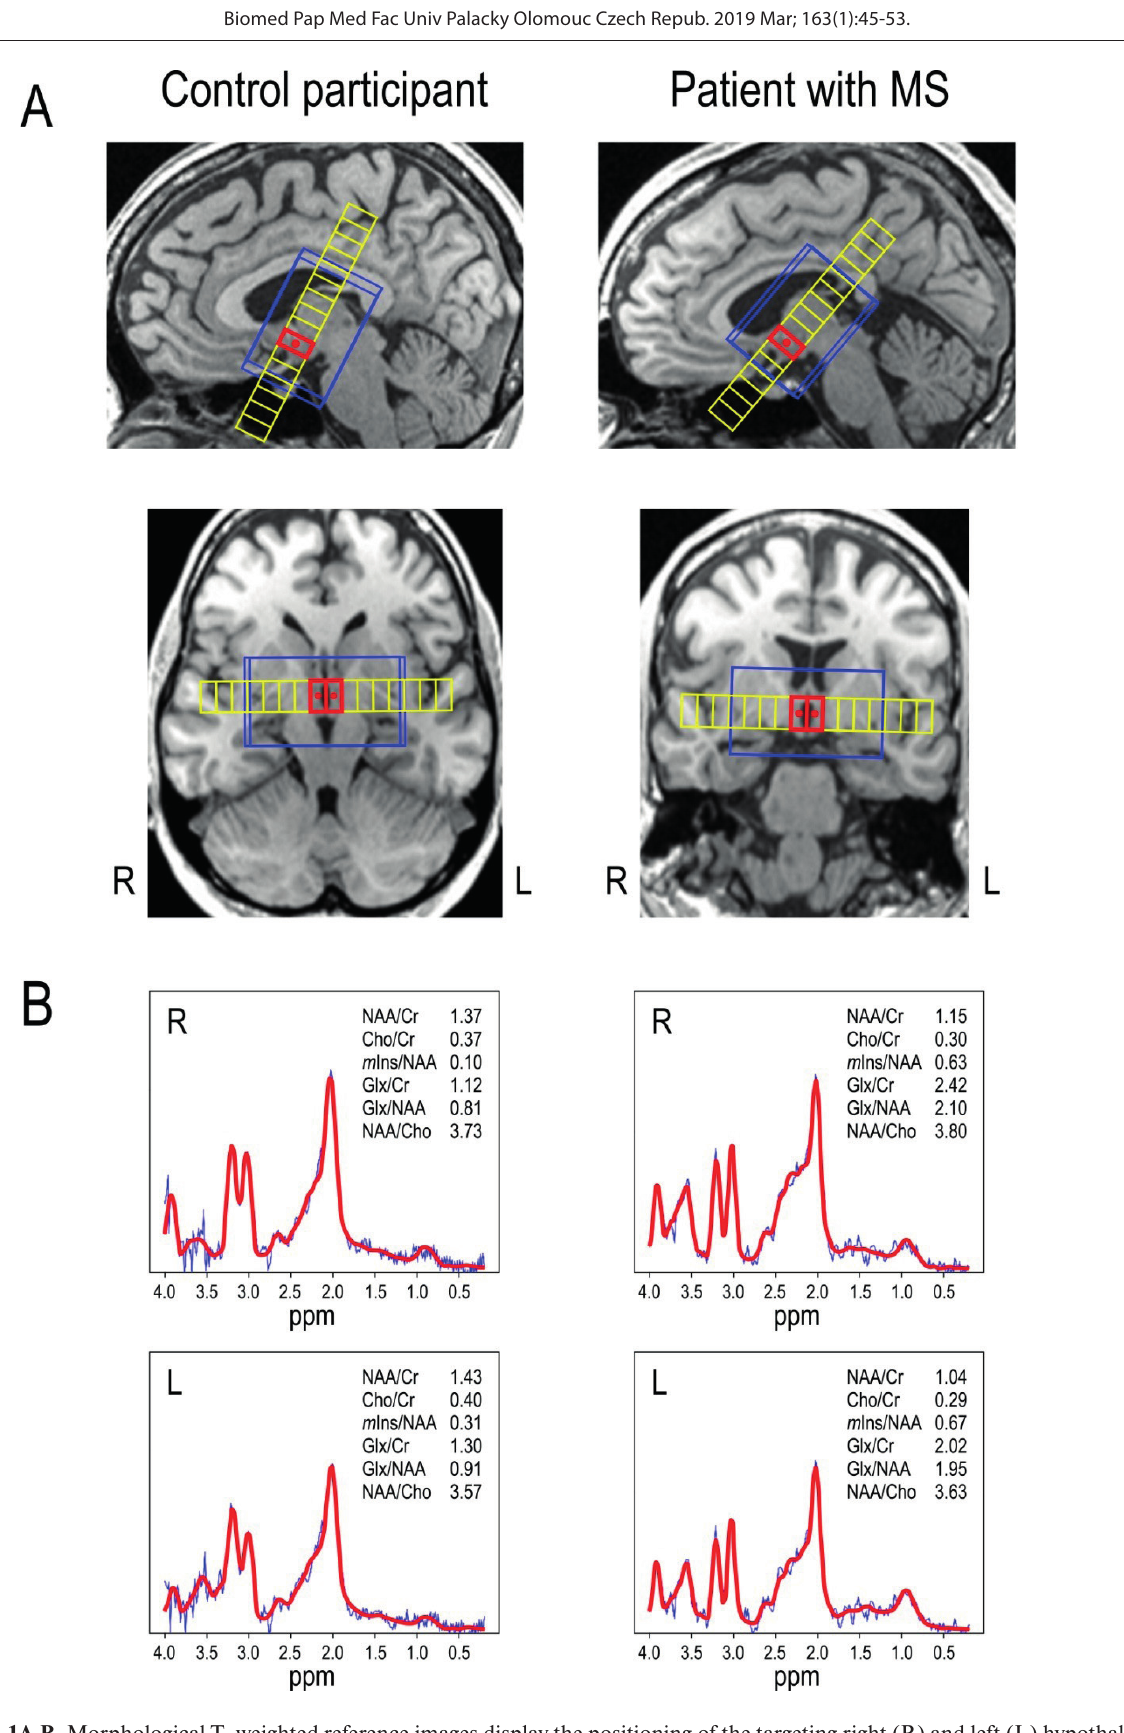
Fig. 1A,B. Morphological T -weighted reference images display the positioning of the targeting right (R) and left (L) hypothalamic 1 1 H-MRS voxels (red squares) in the representative patient with multiple sclerosis and the control participant (A). Acquired matrix size was 10×10×8, interpolated to 16×16×8 (yellow squares) with a nominal voxel size of 10×10×12.5 mm 3 and volumes of interest (VOIs) 50×60×35 mm 3 (blue squares). LCModel fitted spectra (red curves) with relative levels of metabolite ratios corresponding to selected voxels are shown below